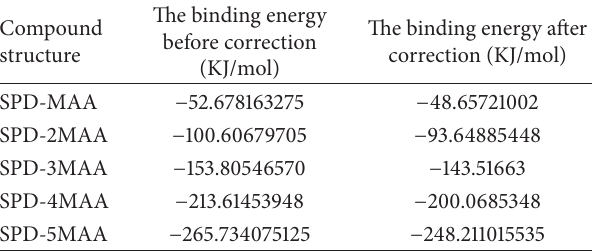
Table 4: Interaction energies of template-monomer complexes before and after BSSE